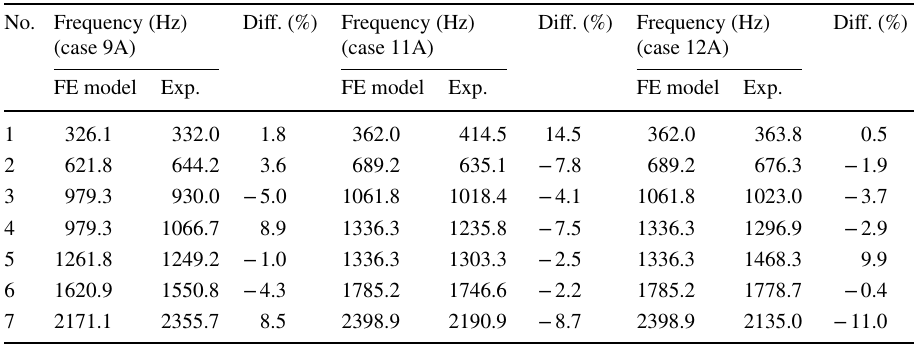
Table 4 The identified natural frequencies of the investigated rock bolt